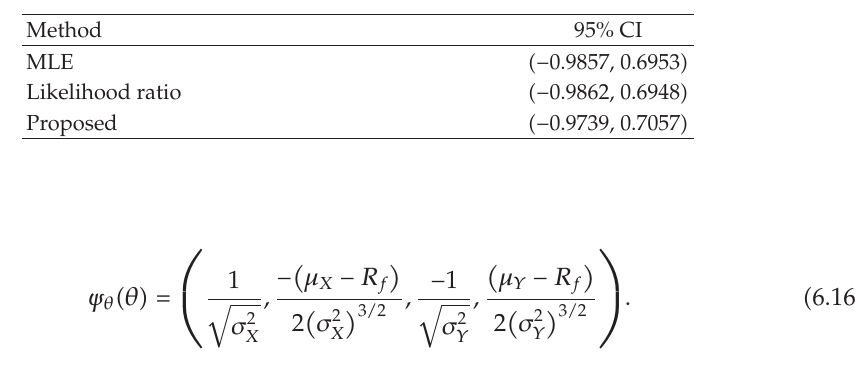
Table 7: 95% Confidence intervals for Sharpe ratio di ff